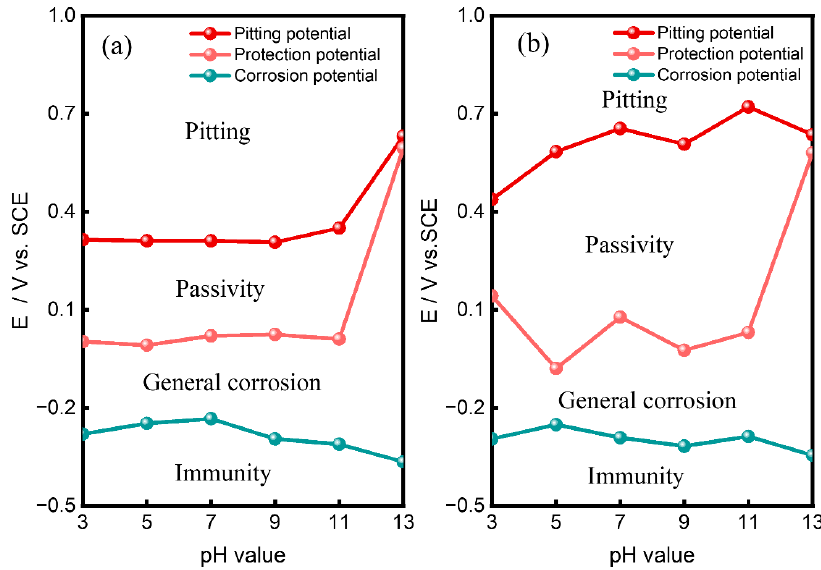
Figure 11. The potential-pH maps of ( a ) the failed tube and ( b ) standard S31608 SS in 0.1 mol/L NaCl.